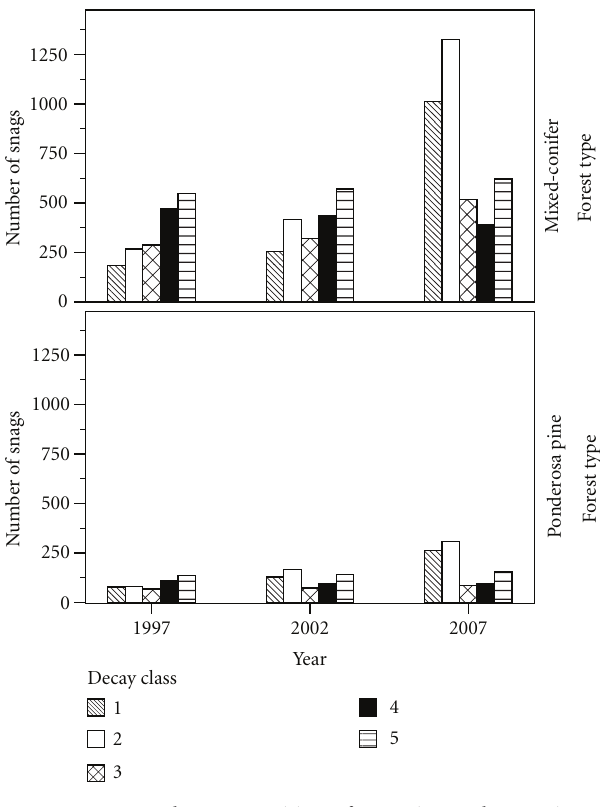
Figure 4: Decay-class composition of snags in northern Arizona mixed-conifer and ponderosa pine forest in 1997, 2002, and 2007. Snags in decay class 1 retained needles (or leaves), twigs, and intact limbs. Decay-class 2 snags retained twigs and intact limbs but lacked needles (or leaves). Class 3 snags had limbs that were largely intact but lacked twigs. Class 4 snags had limbs that were mostly broken, and class 5 snags lacked large limbs entirely. In both forest types, decay-class distributions shifted from dominance by snags in later decay classes (classes 4 and 5) in 1997 to snags in early decay classes (classes 1 and 2) in